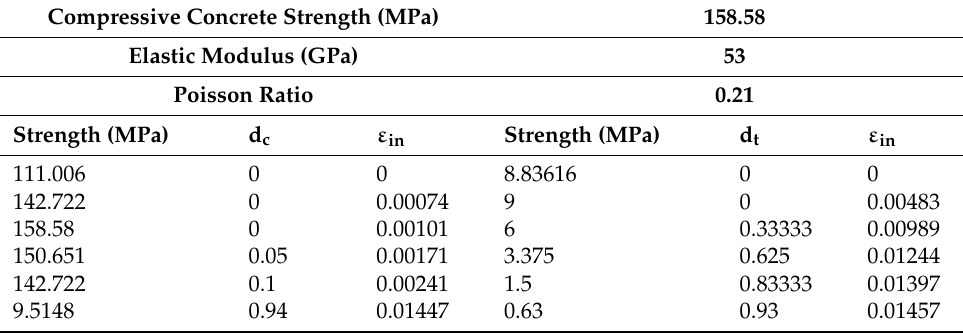
Table 7. Properties of UHPFRC along with CDP model parameters in compression and tension in the tensile